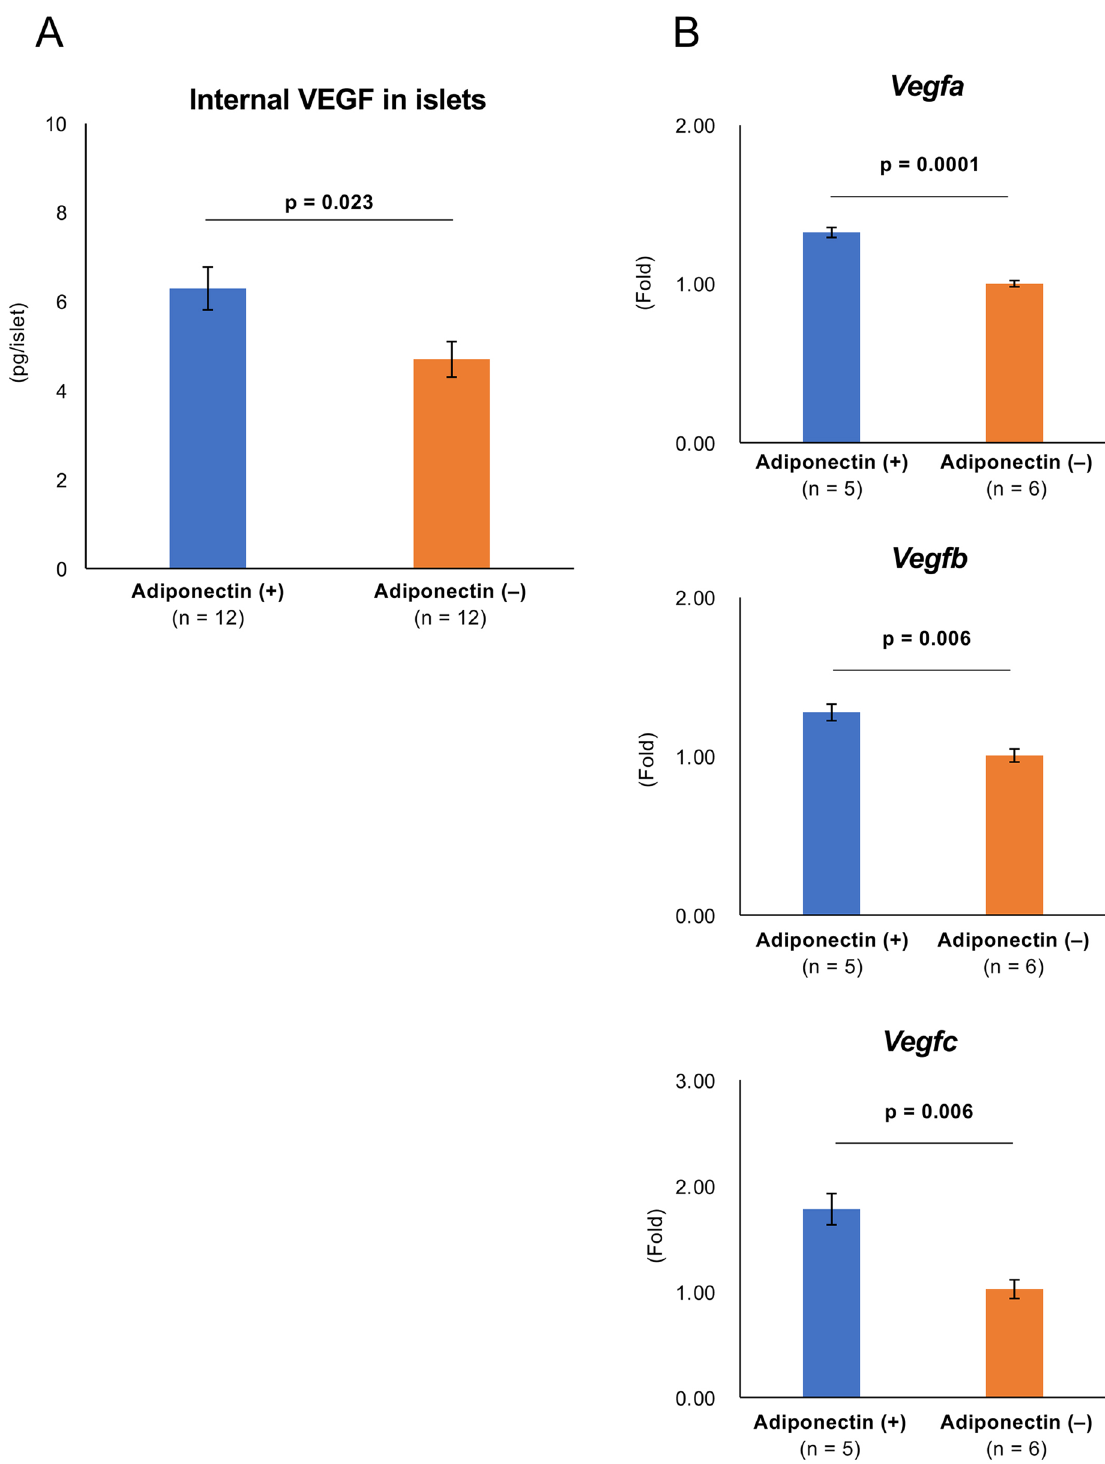
Figure 4. Expressions of angiogenic factors in islets. ( A ) Internal VEGF in islets treated with adiponectin (adiponectin (+), blue) and without adiponectin (adiponectin (−), orange). ( B ) The expression of Vegfa (upper), Vegfb (middle), and Vegfc (lower) in islets as quantified by qRT-PCR. The results were normalized to the β-actin gene and are presented as the fold difference over the detectable Ct value, which was calculated using the ΔΔCt method. Data are presented as means ± standard error of the mean. A p -value < 0.05 was considered statistically